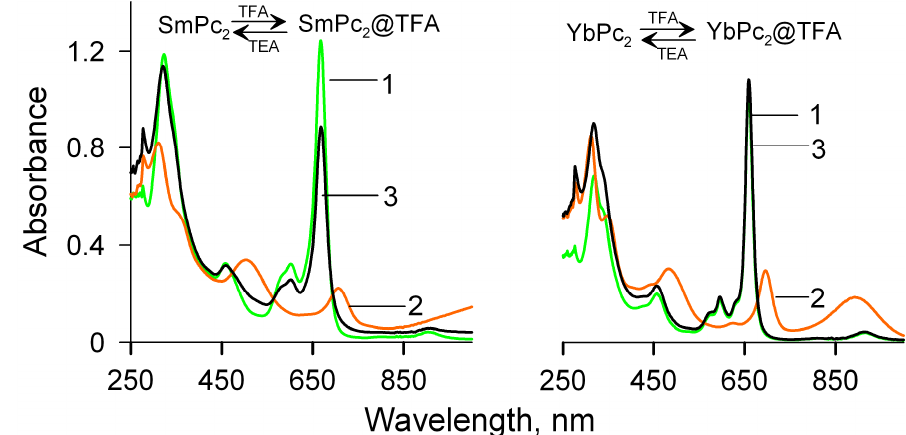
Figure 4. Reversibility of the TFA-conjugate formation: (1) initial form LnPc 2 (green line), (2) the conjugate LnPc 2 @TFA (orange line), (3) recovery of the initial form after adding TEA to the (2) solution (black line); note the partial decay of the SmPc 2 molecular system ( left ) and complete regeneration of the YbPc 2 initial form ( right ). Table 2. Degradation degree, δ (%), of LnPc 2 during the reaction of LnPc 2 @TFA with triethylamine (TEA) in benzene; δ = [(A 0 − A 1 )/A 0 ] × 100%, where A 0 and A 1 refer to the initial and final absorbance (recovered) of LnPc 2 , respectively (see Figure 4 and Figure S4 in SI).